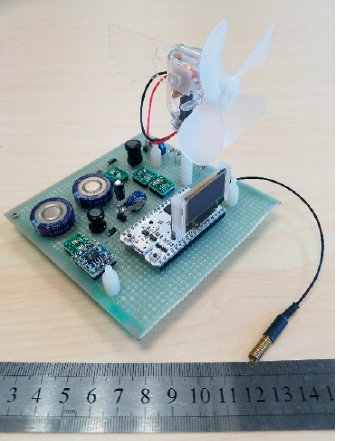
Figure 4. Hardware prototype of the Wind-powered sensor node.